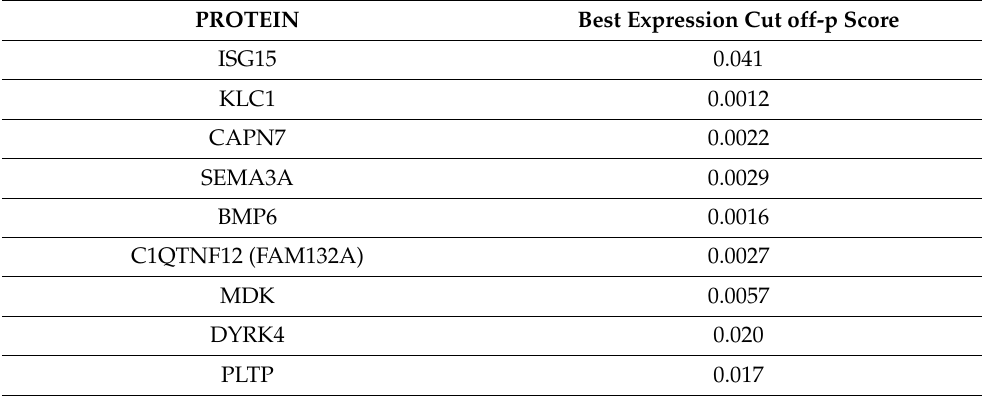
Table 1. HSPs associated with poor prognosis (HSP-pp). The listed proteins from Table 1 are associated at a statistical significance with poor prognosis in HCC patients.